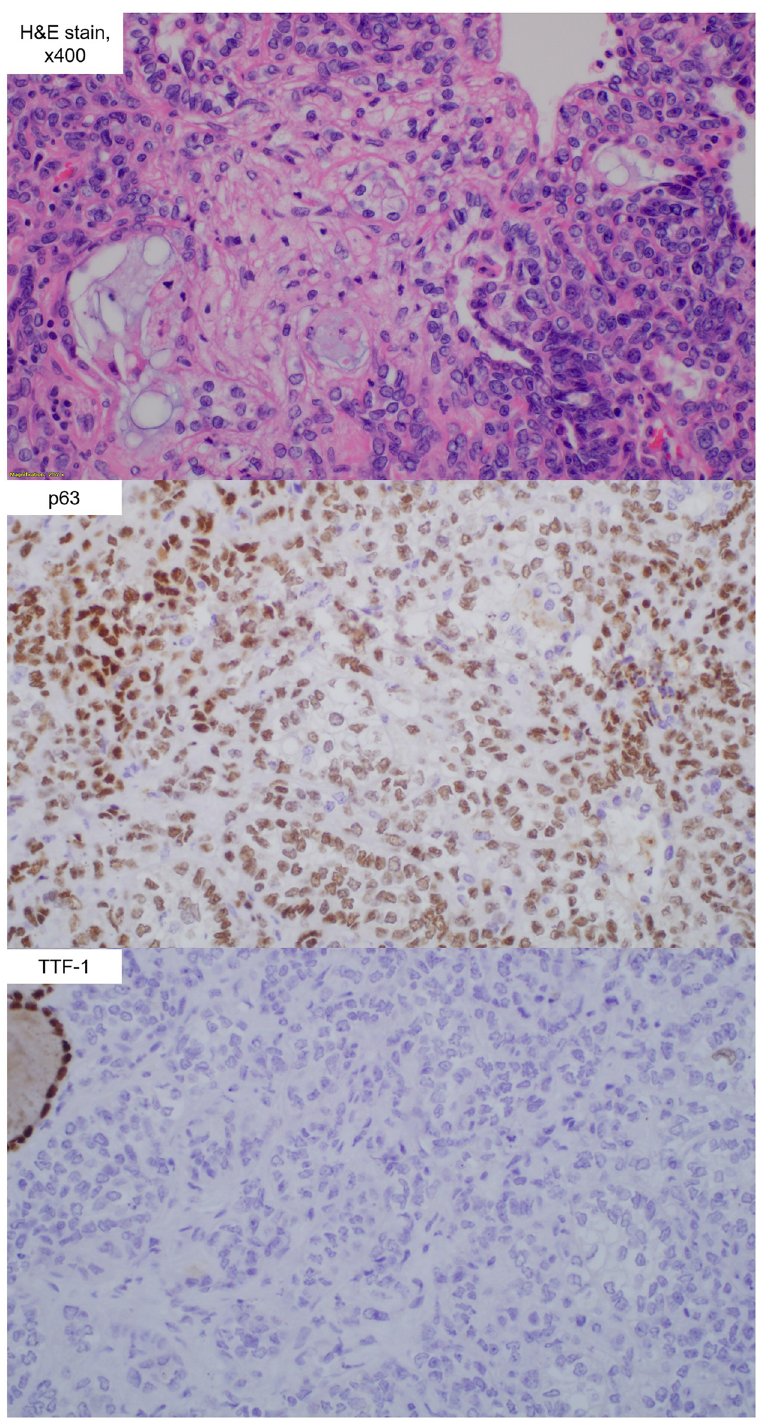
Fig 2. The histopathologic finding (hematoylin and eosin stain, x 400) of squamous cell carcinoma from rat #1. The squamous cell carcinoma tumor cells were positive for p63 and negative for TTF-1.